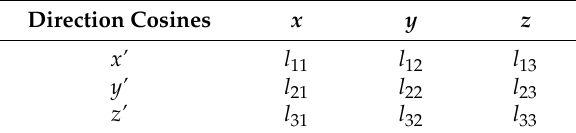
Table 2. Direction cosines between the two coordinate